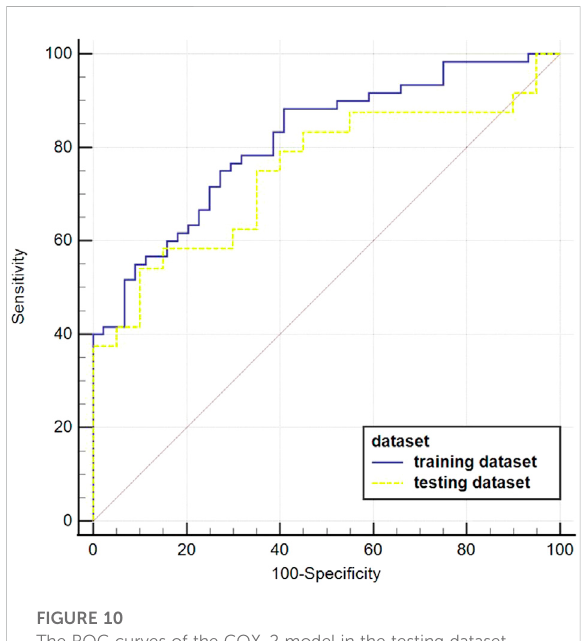
FIGURE 10 The ROC curves of the COX-2 model in the testing dataset. The blue ROC curve represents the training dataset, the yellow ROCcurverepresentsthetestingset.Bothofthembehavedwellin predictingCOX-2expressionlevelsinthetrainingdatasetand testing dataset (AUC = 0.814, p < 0.001; AUC = 0.748, p = 0.001,